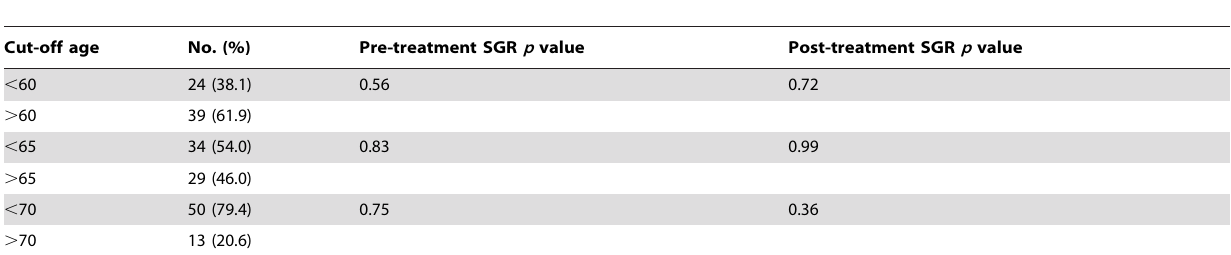
Table 3. Independent samples t-test for pre-treatment and post-treatment SGRs, with SGRs classified into two groups based on cut-off age